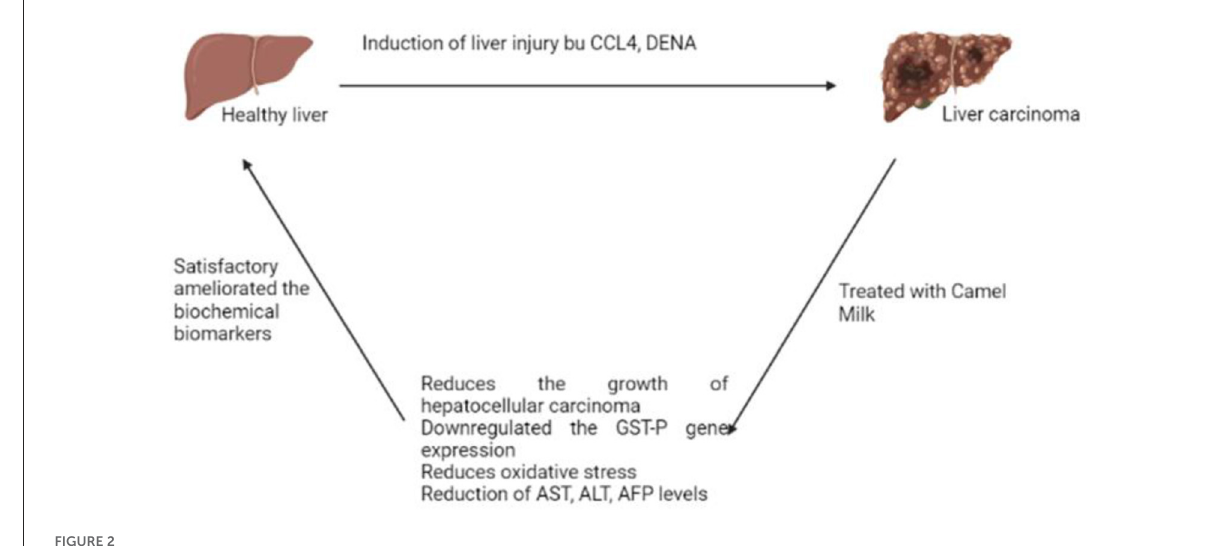
FIGURE2 Effect of camel milk on liver